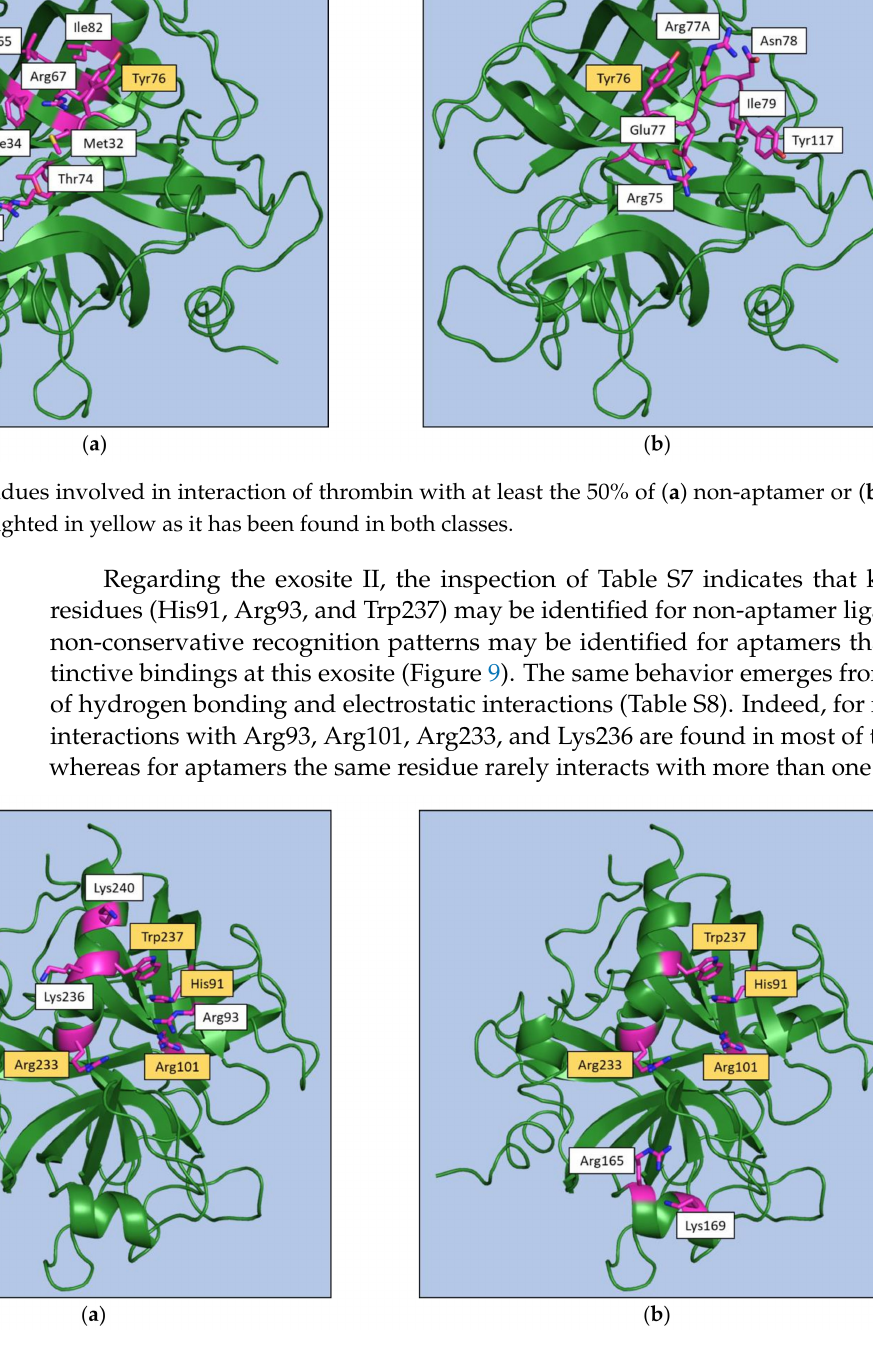
Figure 9. Exosite II residues involved in interaction of thrombin with ( a ) at least the 50% of the non-aptamer ligands or ( b ) the two aptamers bound to this exosite. Residues that have been found in both classes are highlighted in